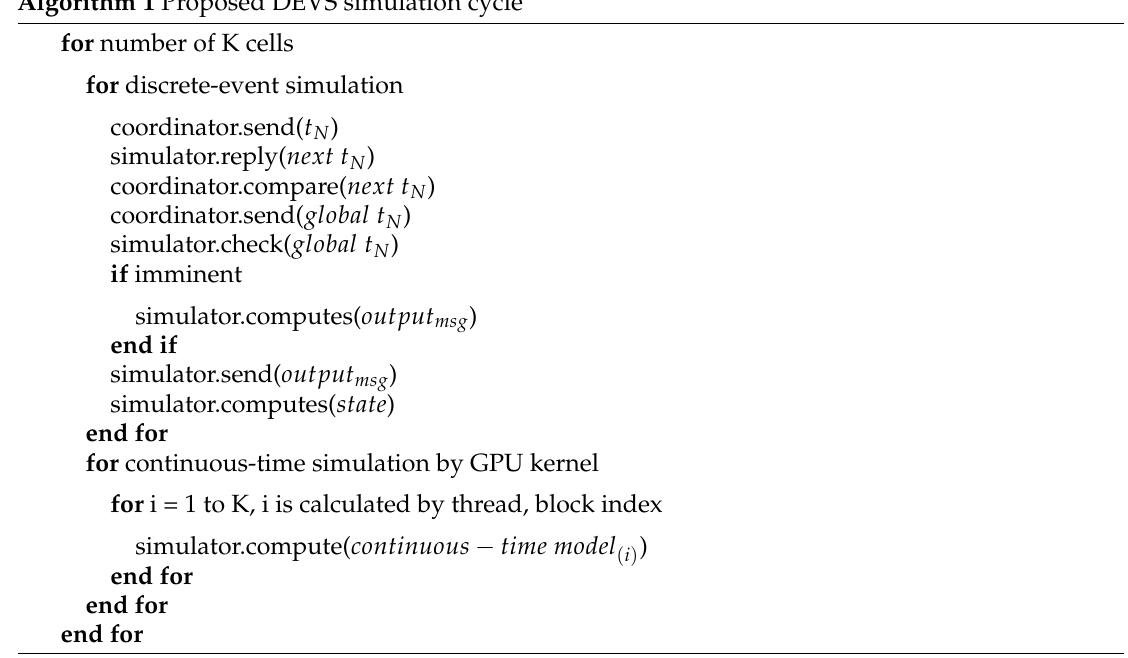
Algorithm 1 Proposed DEVS simulation